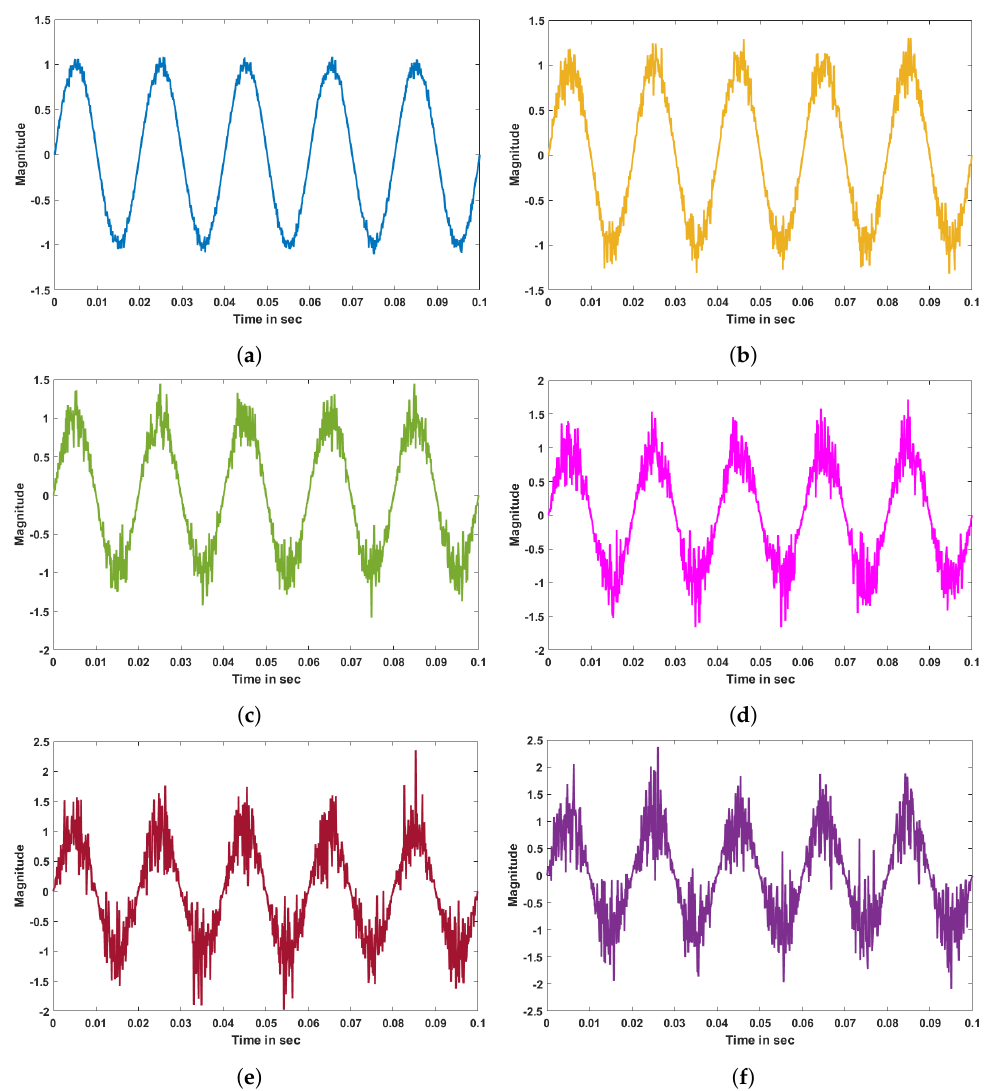
Figure 2. Noise signals used for dataset preparation. ( a ) Noise level 5%. ( b ) Noise level 15%. ( c ) Noise level 20%. ( d ) Noise level 30%. ( e ) Noise level 40%. ( f ) Noise level